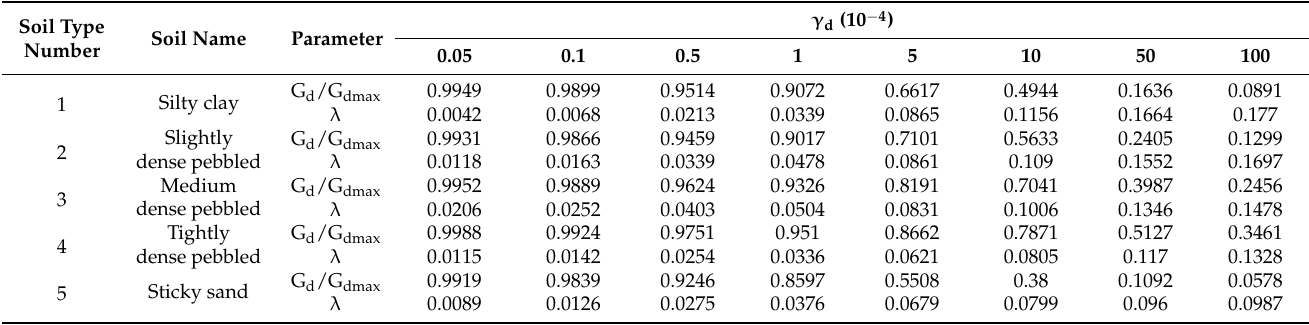
Table 2. Dynamic nonlinear parameters for different soil